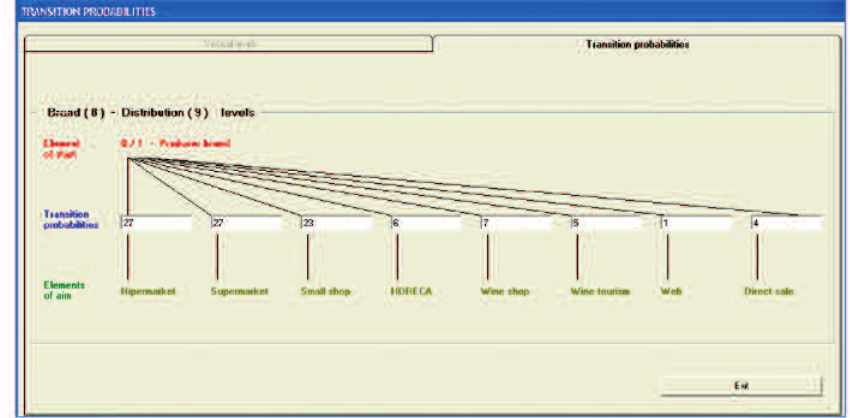
Figure 4. Definition of transition probabilities (%) by the sector levels